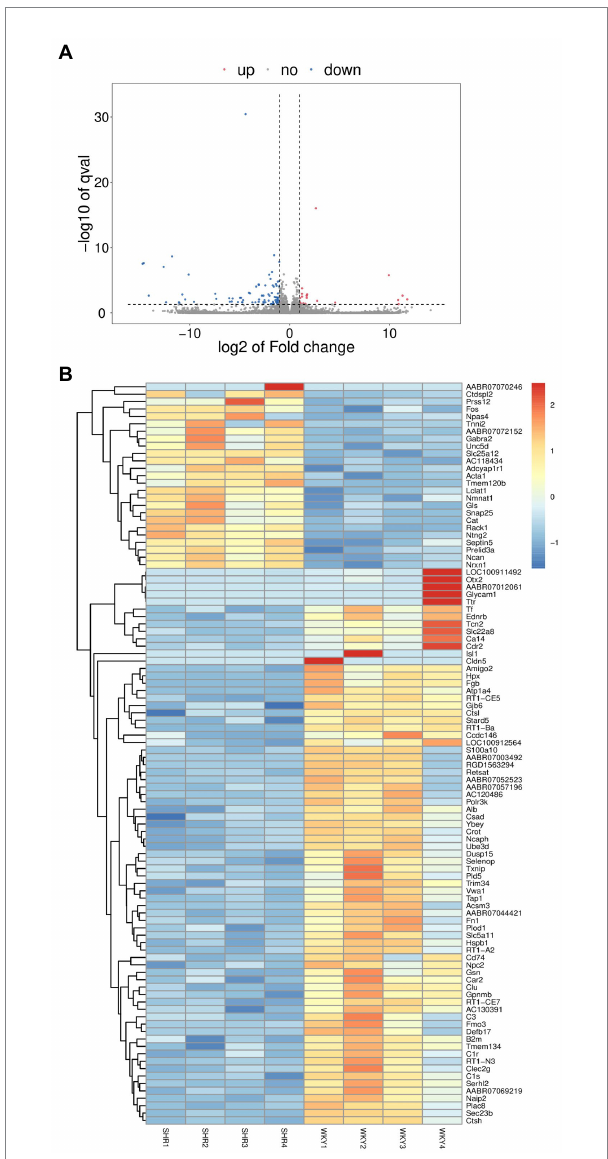
FIGURE 6 (A) Volcano plot of differentially expressed genes. (B) Heatmap of differentially expressed